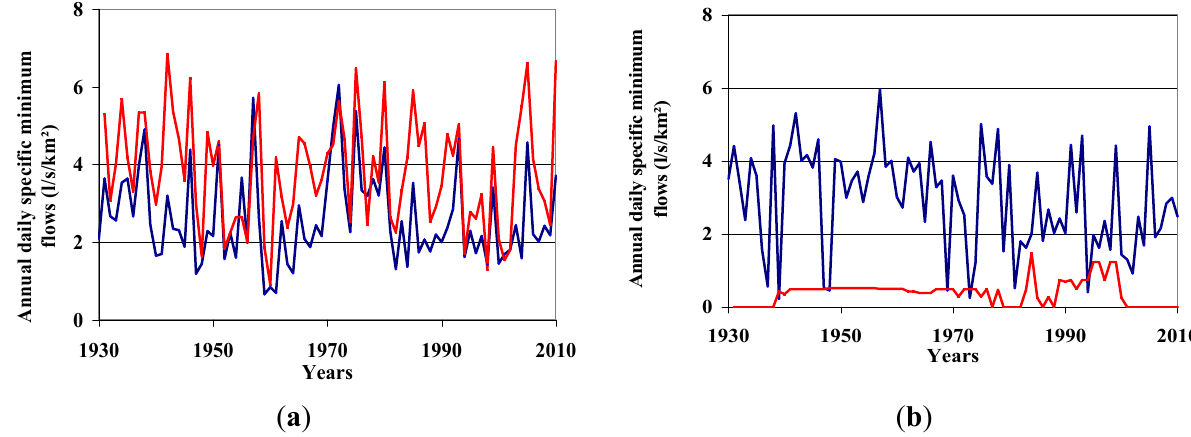
Figure 4. Comparison of the temporal variability of AMEF magnitude from 1930 to 2010 ( a ) the L’Assomption River (blue curve) and Matawin River upstream from the Matawin dam (red curve); ( b ) (specific discharge) in the Ouareau River downstream from the Rawdon dam (blue curve) and in the Matawin River downstream from the Matawin dam (red